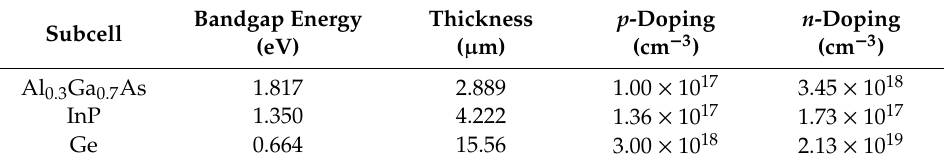
Table 1. Input parameter for PC1D program.